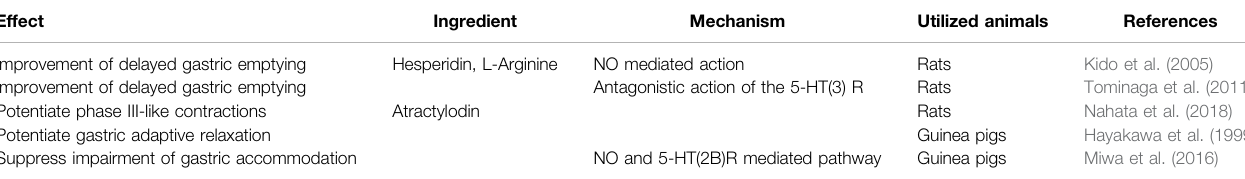
TABLE 1 | List of in vivo studies that examine the ef fi cacy of rikkunshito on motor patterns. Effect